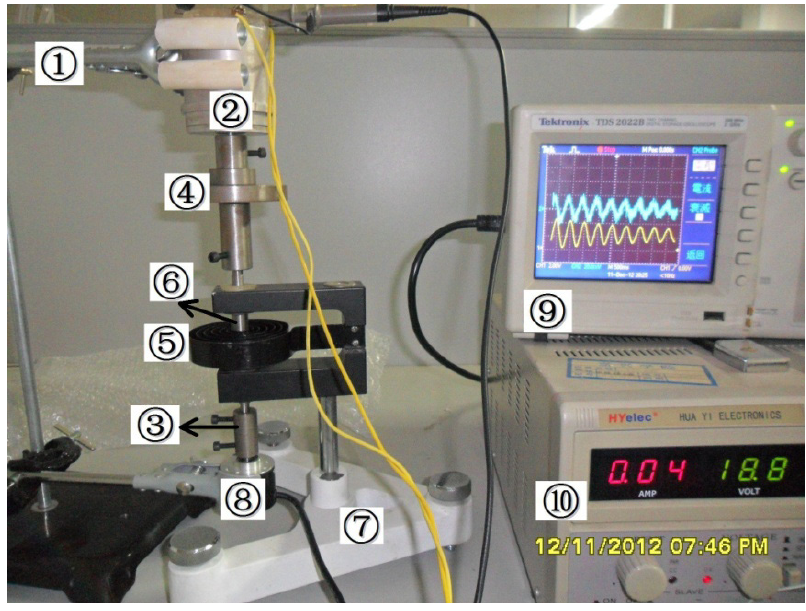
Figure 8. The calibration equipment of angular acceleration